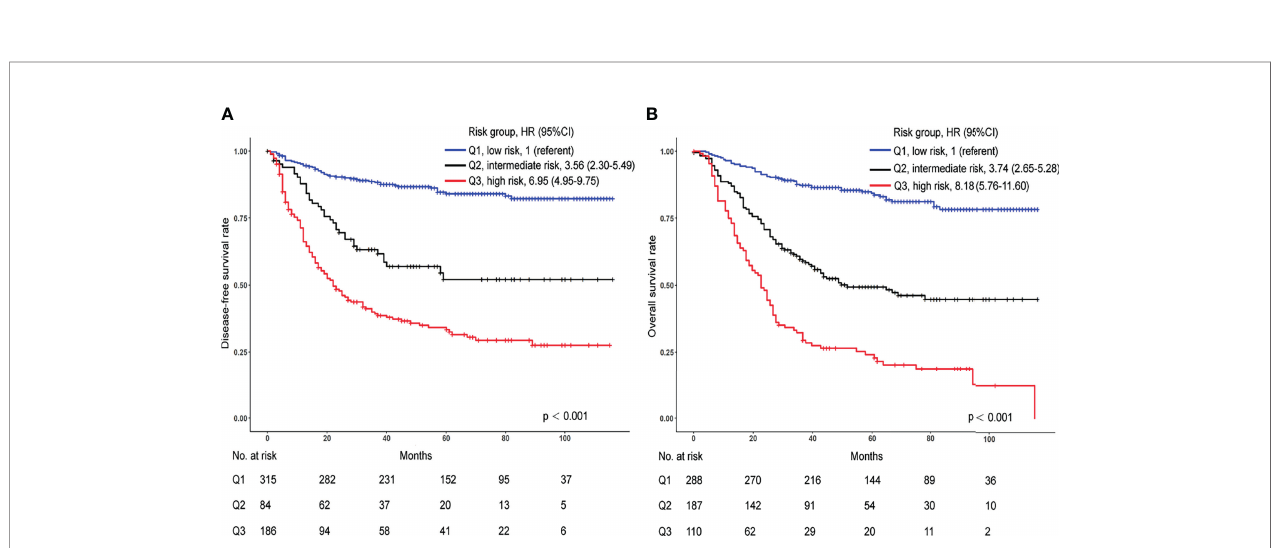
FIGURE 6 | Kaplan-Meier curves for differences in patient survival in the high-, intermediate-, and low-risk groups from the internal cohort. (A) Kaplan-Meier curves for DFS. (B) Kaplan-Meier curves for